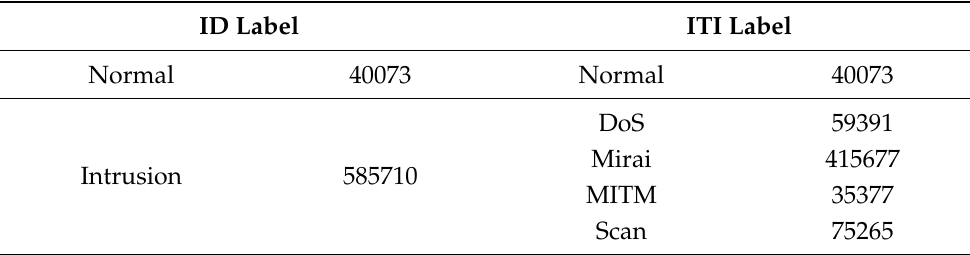
Table 2. IoTID20 Dataset instances including the ID label and ITI